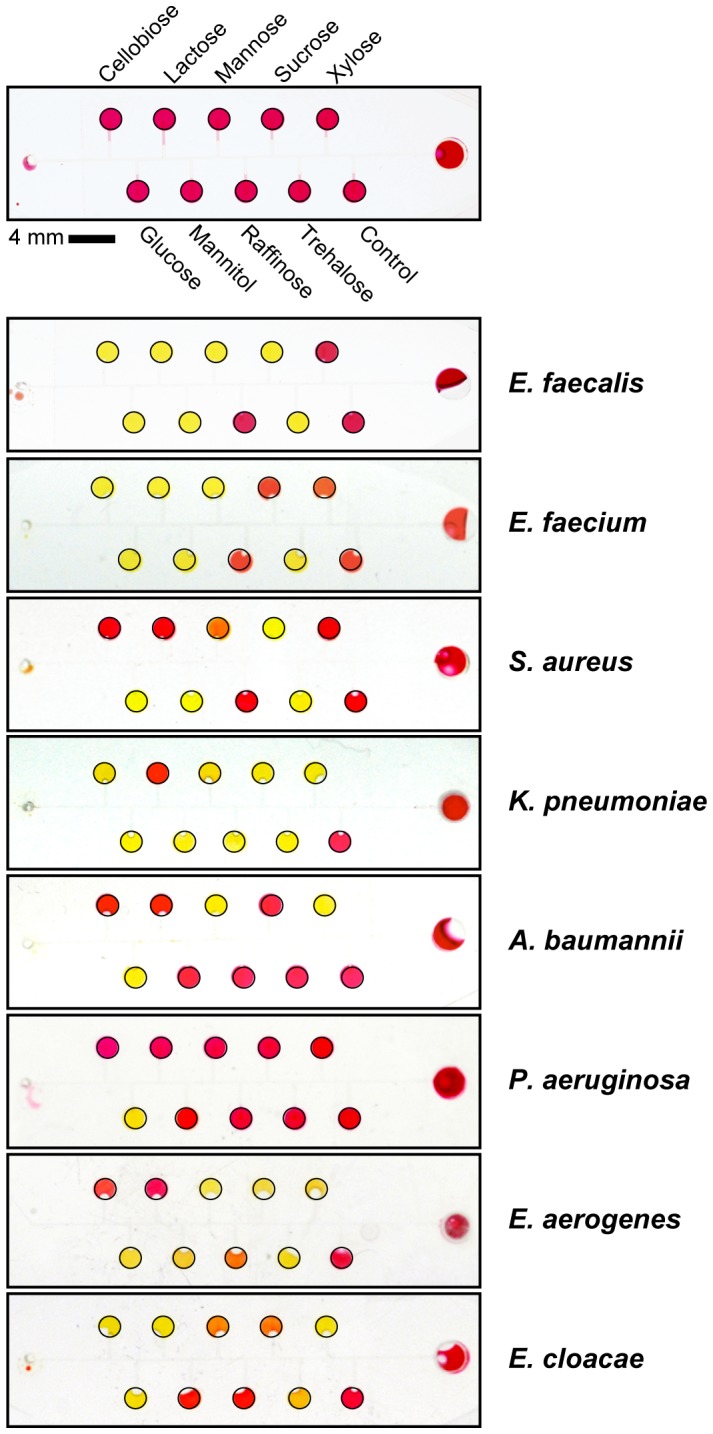
Different colorimetric profiles of ESKAPE pathogens in BacChips.We loaded devices using a single isolated colony suspended in 100 µL of loading media consisting of 25% LB and 0.05% phenol red in saline. We incubated BacChips at 37°C and imaged the devices after 4 h. Yellow microchambers indicate a decrease in the pH below 6.8, which arises from fermentation of the saccharide; red microchambers match the control and indicate no fermentation (pH 8.2). Orange microchambers indicate that the bacterial are slowly metabolizing the saccharide and the pH is >6.8. Black lines were added to the edge of each device and microchamber to aid in visualization.